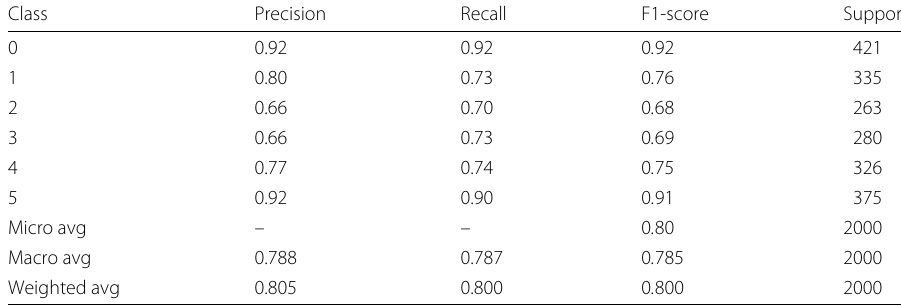
Table 2 Classification